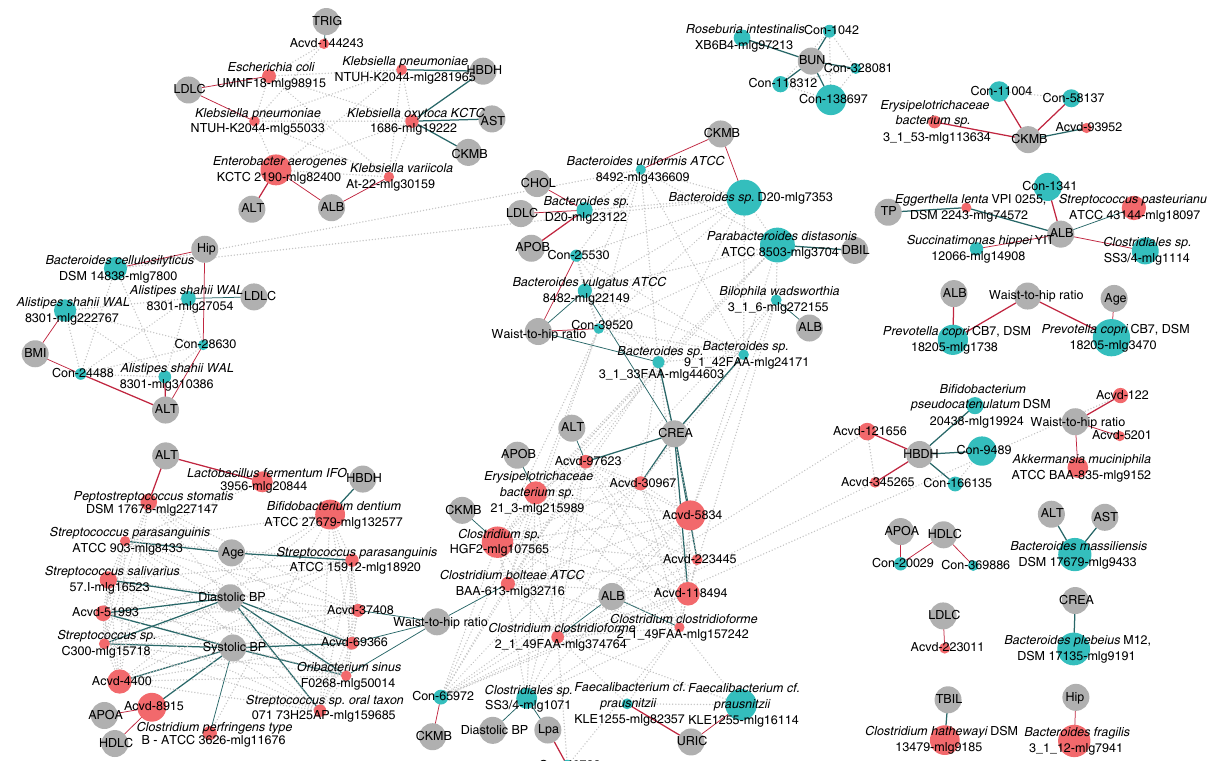
Fig. 4 Associations between ACVD-enriched or depleted MLGs and clinical indices. Differentially enriched MLGs ( q -value < 0.05, FDR-controlled Wilcoxon rank-sum test, Fig. 2, Supplementary Data 3) were analyzed for associations with clinical indices (Supplementary Data 1). ACVD-enriched MLGs are represented by red circles , and control-enriched MLGs are represented by cyan circles . The size of each circle indicates the number of genes in an MLG (100 – 3723, detailed in Supplementary Data 3). Associations were de fi ned as permutational Wilcoxon rank-sum test P -value for Spearman correlation < 0.05, | Spearman ’ s cc | ≥ 0.2 and selected by an MLG-based RFCV model for the clinical index. The thicker lines had a stronger association of | Spearman ’ s cc | > 0.25. Green lines indicate positive association, and red lines — negative associations. Dotted grey lines indicate correlations between MLGs in the control samples, as shown in Fig. 2. Clinical indices: age, ALB (albumin), ALT, APOA, APOB, AST, BMI (body mass index), BUN (blood urea nitrogen), CHOL (cholesterol), CKMB, CREA (creatinine), DBIL (direct bilirubin), diastolic BP (diastolic blood pressure), HBDH, HDLC (high-density lipoprotein cholesterol), hip (hip circumference), LDLC (LDL cholesterol), Lpa (lysophosphatidic acid), systolic BP (systolic blood pressure), TBIL, TP (total protein),